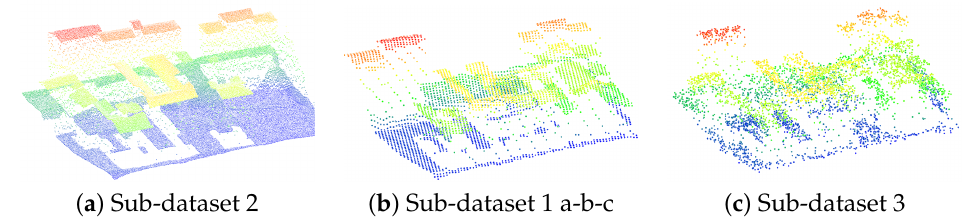
Figure 5. Samples of sub-dataset 2 with high resolution ( a ), sub-dataset 1 with low resolution ( b ) and sub-dataset 3 with low resolution and high noise ( c ). Height is shown in